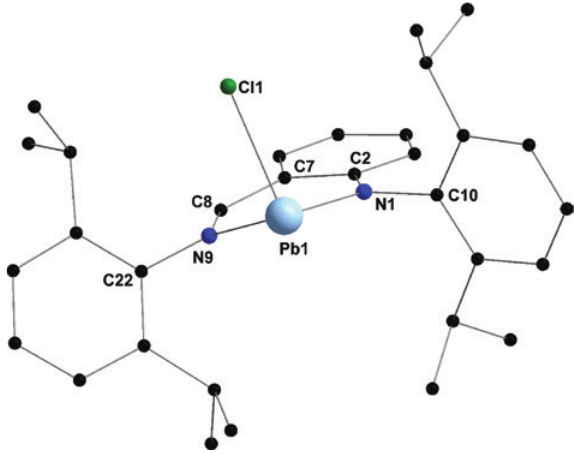
Figure 2: Molecular solid-state structure of one of the two inde- pendent components ( 1a ) in [{N^N iPr }PbCl] ( 1 ). H atoms are omitted for clarity. Selected interatomic distances (Å) and angles (degrees): Pb1-N1 = 2.246(6), Pb1-N9 = 2.336(6), Pb1-